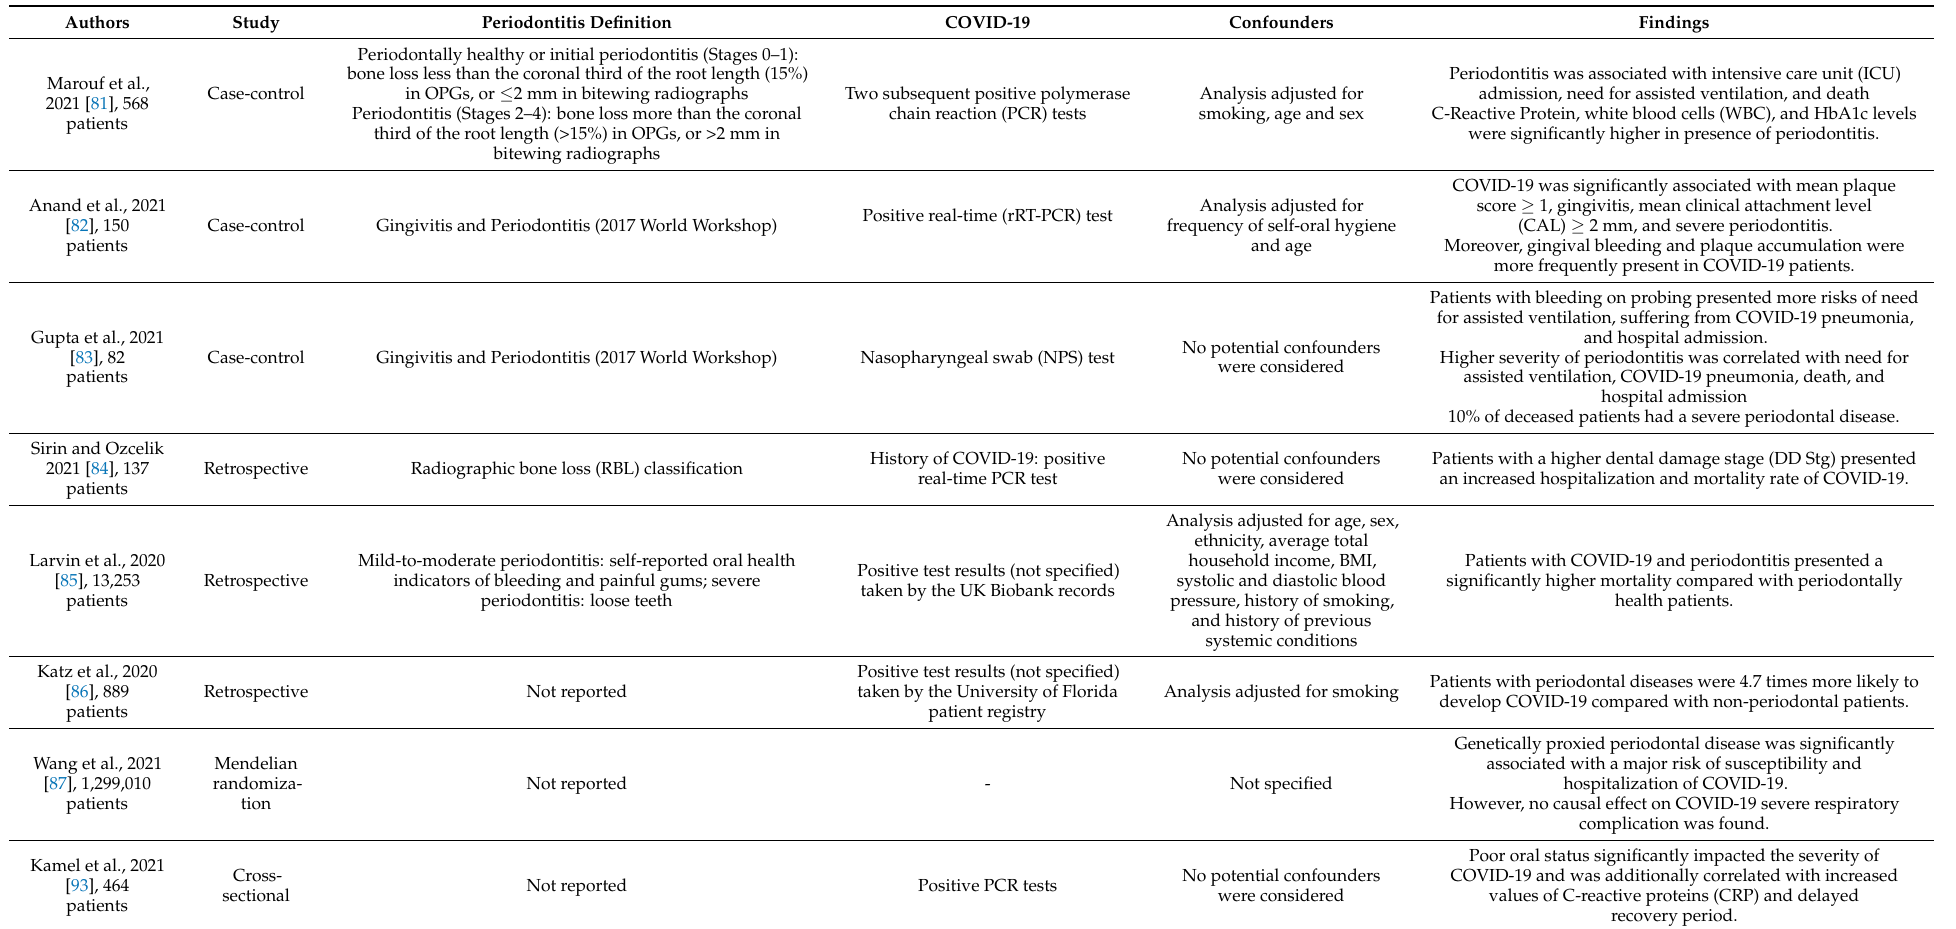
Table 2. Summary of existing studies investigating the possible association between COVID-19 and